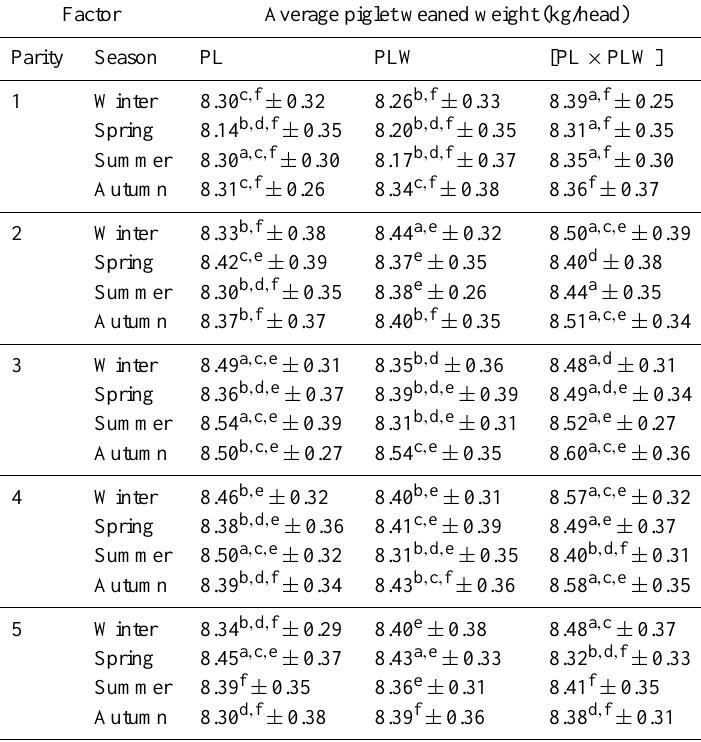
Table 5. The impact of season, parity and breed on average piglet weaned